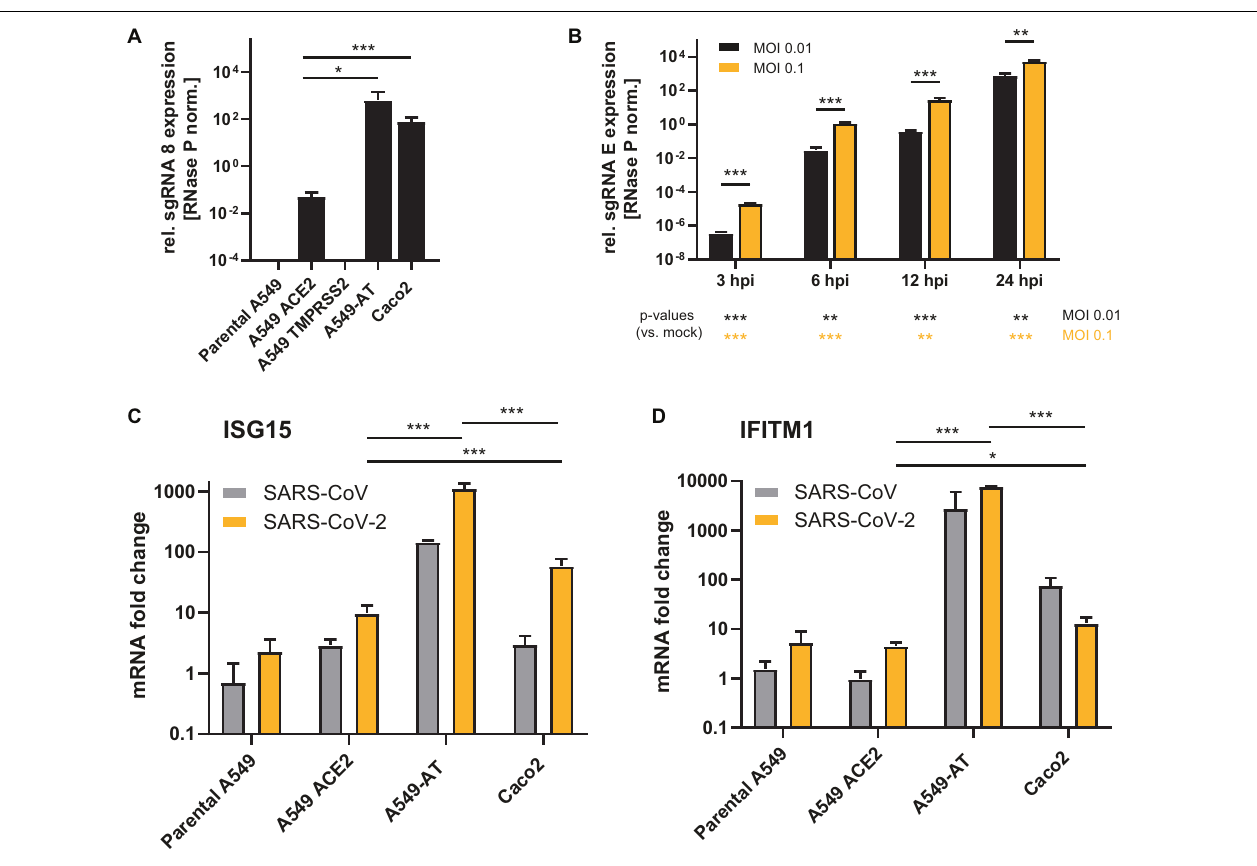
FIGURE 4 | Susceptibility of A549 derived cell lines to SARS-CoV-2. Caco2, A549 cells, and derivates were infected with SARS-CoV or SARS-CoV-2 strain FFM1, respectively and total RNA was isolated 24 h post infection or as indicated (0.01 MOI or as depicted). (A,B) Relative expression of SARS-CoV-2 sgRNA was used as surrogate markers to quantify active viral replication. (C,D) Relative expression of ISG15 and IFITM1 (fold change) were determined using RT-qPCR to monitor interferon signaling in SARS-CoV and SARS-CoV-2 infected cells (MOI 0.1). * p < 0.05, ** p < 0.01 and *** p <